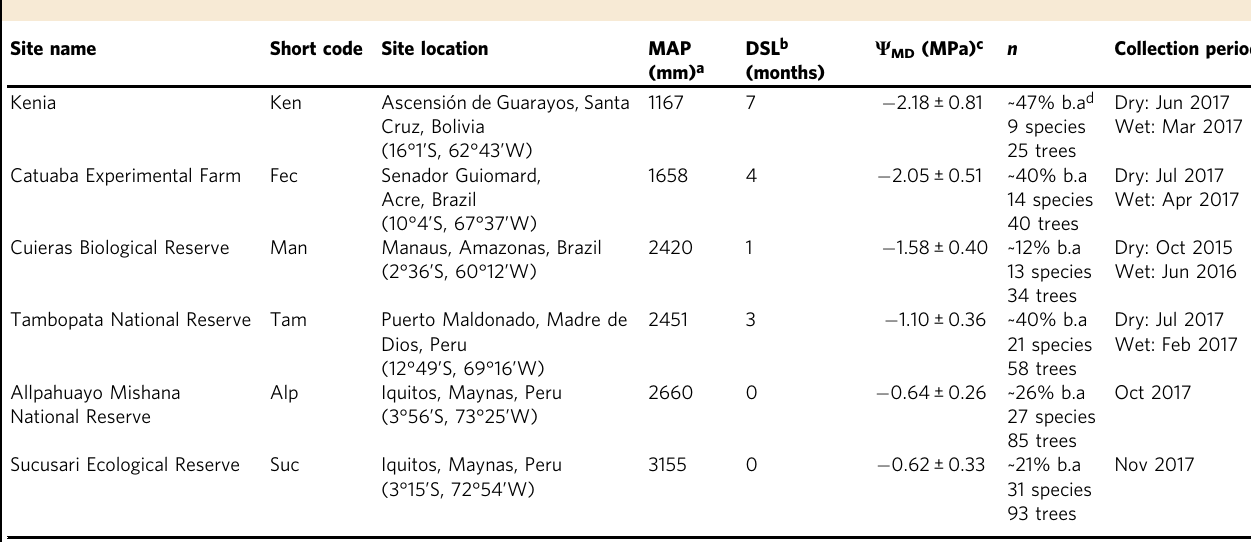
Fig. 1 Location of sampled sites and monthly precipitation. The map depicts mean annual precipitation in South America (mm year − 1 ). The Amazon basin is bounded by the black outline. Bar plots show the monthly precipitation for each site, blue represents precipitation >100 mm month − 1 and red ≤ 100 mm month − 1 . Data for the map and bar plots are from WorldClim v2 (1970 – 2010, 30 s resolution) 51 . Table 1 Site